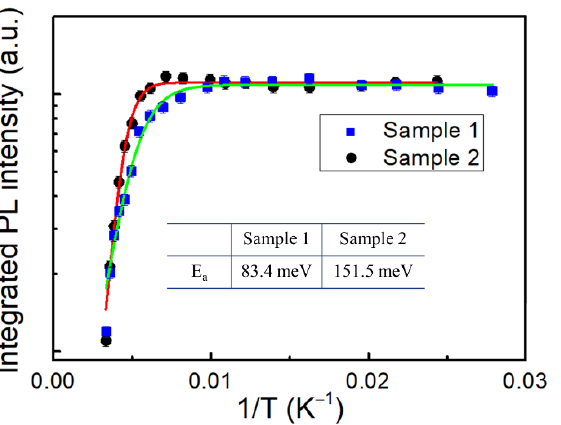
Figure 4. Arrhenius plots of the integral PL intensity dependence on temperature for Sample 1 and Sample 2. Error bar is calculated standard error.